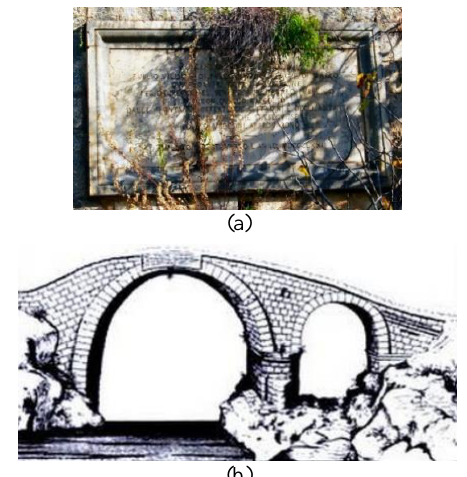
Figure 4. Historical information on the bridge. a) table on the bridge; b) image of the original structure of the bridge taken from the book “Strade romane, ponti e viadotti”, Quilici, L., & Gigli, S. Q.,1996